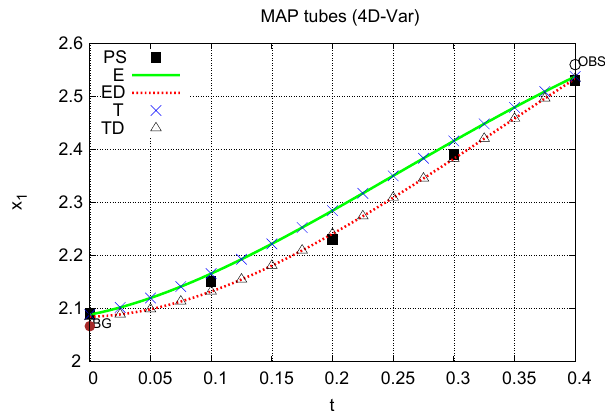
Figure 5. Most probable tube derived by 4D-Var (Rössler